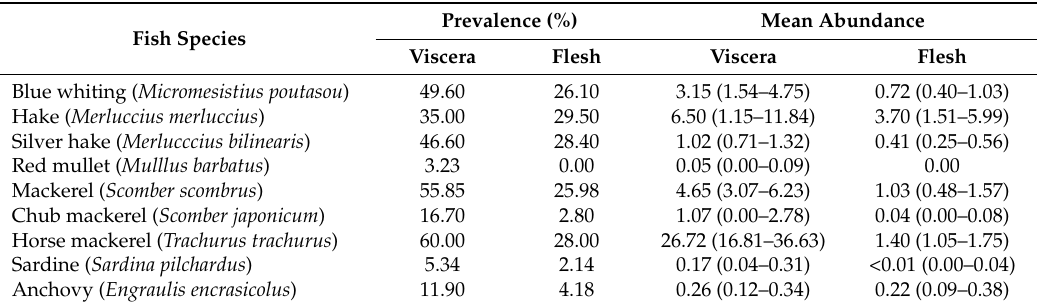
Table 3. Prevalence (%) and mean abundance and 95% confidence intervals of Anisakis type I larvae in the fish species analysed with respect to the microhabitat of parasitation.